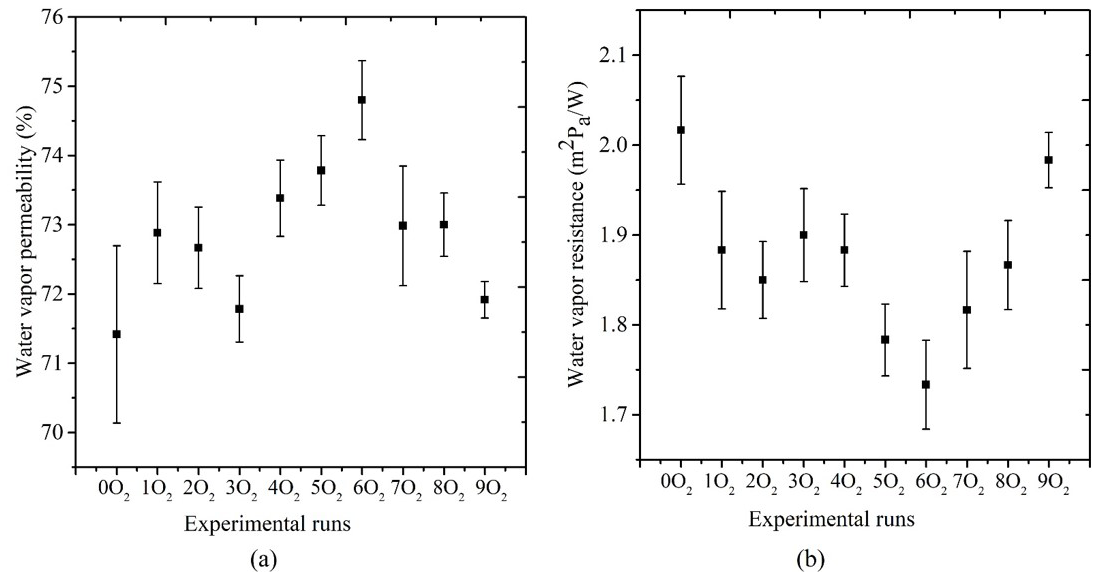
Figure 4. Oxygen plasma on water vapor permeability (a) and resistance (b) of